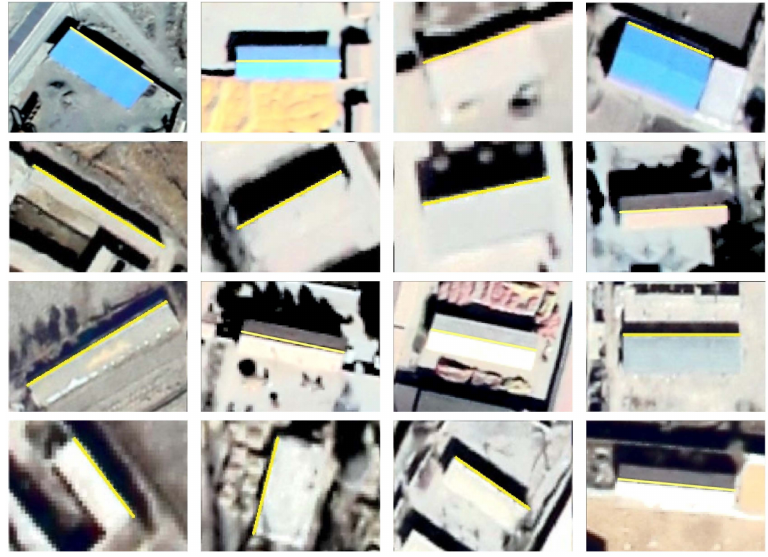
Figure 5. The 16 corresponding 2D line segments (there are a total of 50 due to image overlapping, and here illustrated are the 16 ones corresponding to the 3D line segments shown in Figure 4) extracted in the UAVRS